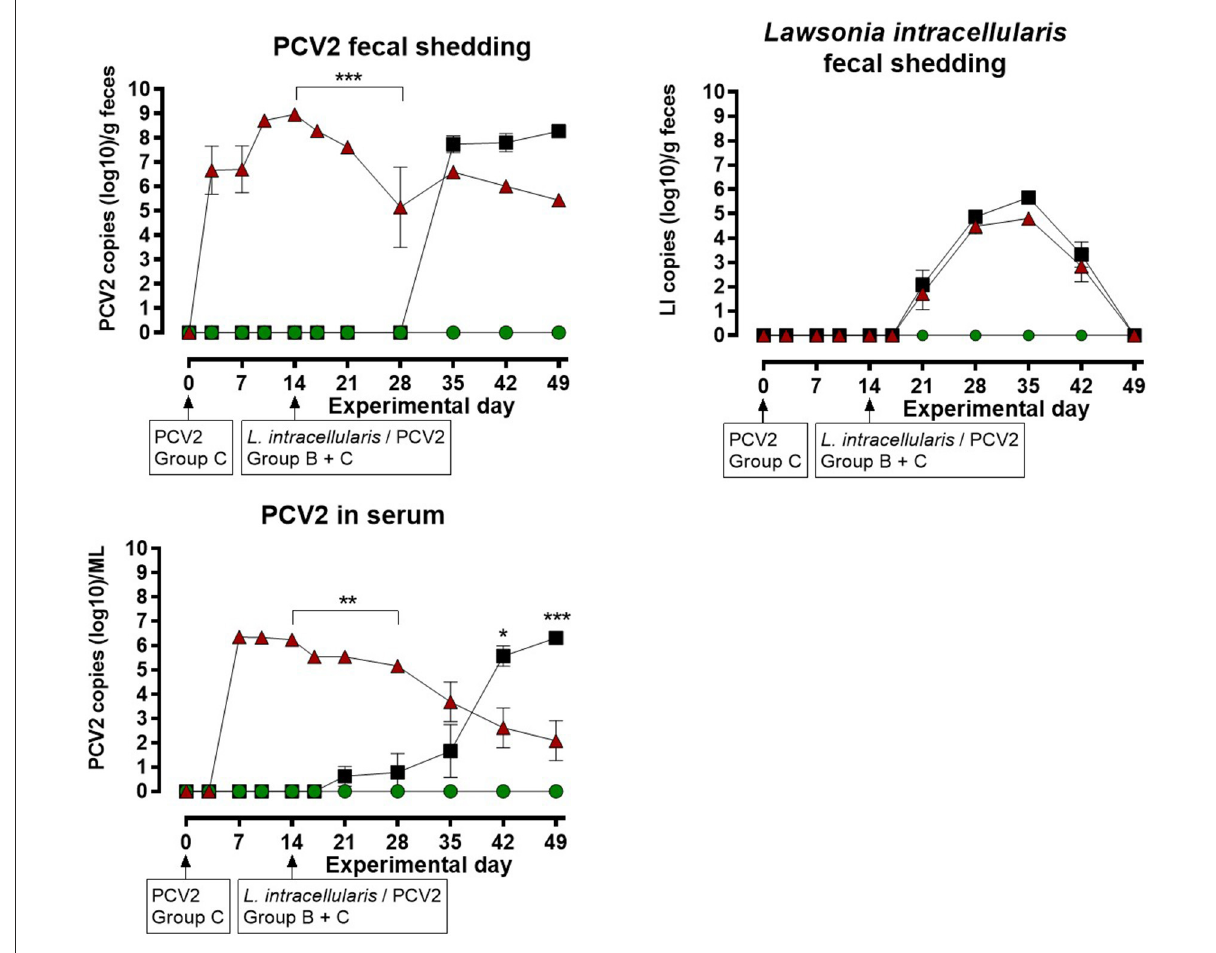
FIGURE2 Porcine circovirus type 2 (PCV2) copies in feces and serum, and number of Lawsonia intracellularis in feces by quantitative PCR for the three groups: A ( ), B ( ), C ( ) as a function of experimental day. Each dot represents mean ± SEM of eight pigs. Significant results ( p < 0.05), ( p < 0.01) and ( p < 0.001) are marked by *, ** and ***,